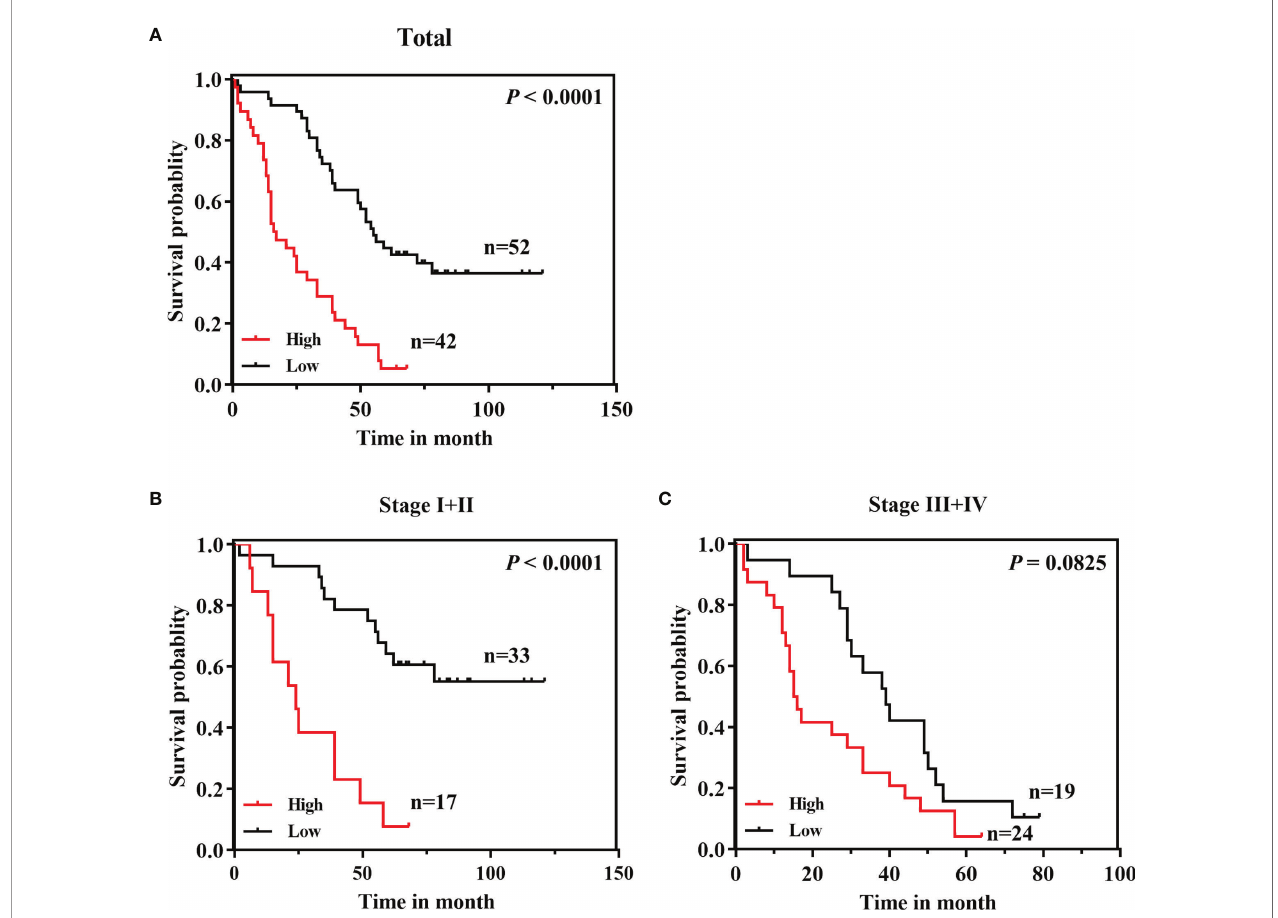
FIGURE 4 | A high CPN2 protein expression was signi fi cantly associated with poor survival in clinical lung adenocarcinoma patients from our cohort by Kaplan – Meier survival curves. (A) The Kaplan – Meier survival curves based on a log-rank test showed that lung cancer patients with a high CPN2 expression had poorer survival than those with a low CPN2 expression ( P < 0.0001). (B) Kaplan – Meier curves of lung adenocarcinoma patients with TNM stages I and II ( P < 0.0001). (C) Kaplan – Meier curves of lung adenocarcinoma patients with TNM stages III and IV ( P > 0.05).